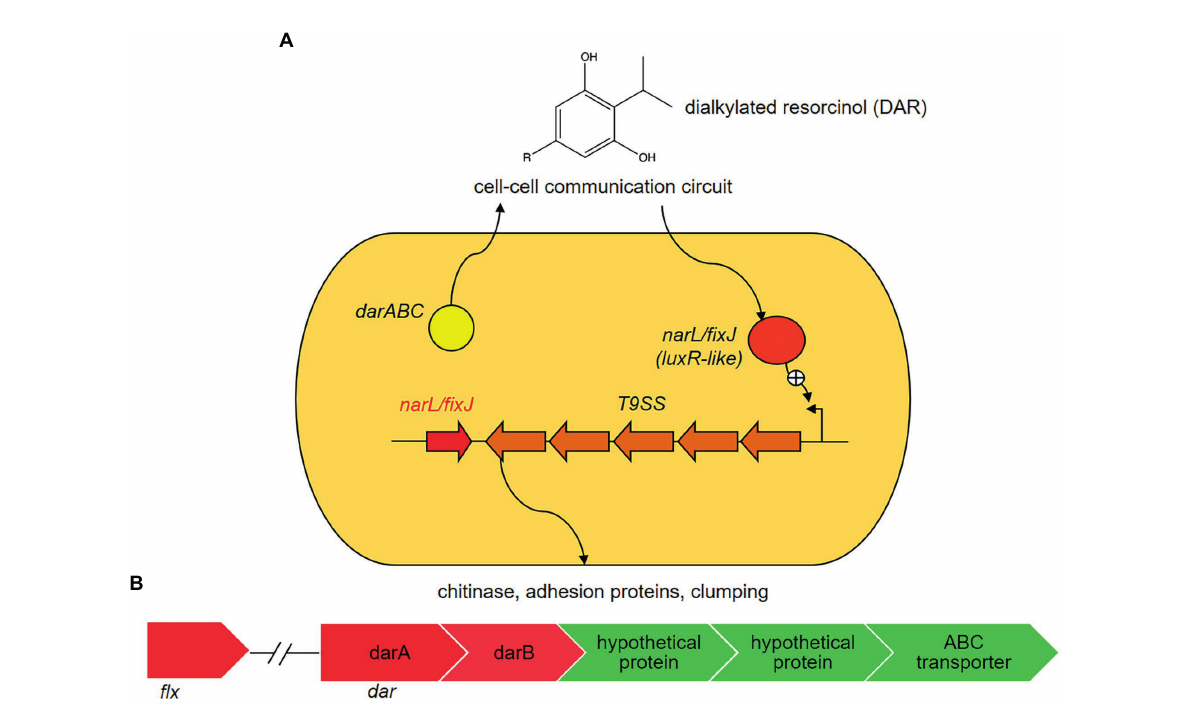
FIGURE 4 Proposed model of flexirubin or dialkylresorcinol (DARs) biosynthesis in Dyadobacter sp. HH091. In the proposed model, Dyadobacter sp. HH091 communicates via DARs and represents a novel quorum sensing (QS) circuit (Brameyer et al., 2015). It consists of the dar operon and a neighboring gene encoding a luxR solo ( narL/fixJ ). NarL/FixJ shares 46% identity and 47% similarity with the LuxR solo PluR of P. luminescens (IMG 2597490348), LuxR-type receptor serving for QS. The proposed QS circuit genes, adjacent to T9SS genes, genes affiliated with gliding motility and protein secretion, possibly upregulates several mechanisms, including T9SS, gliding motility and protein secretion. (A) Expression levels of DEGs involved into flexirubin biosynthesis: dar and flx clusters, and transport systems (ATP binding cassettes (ABC) and hypothetical proteins). Color